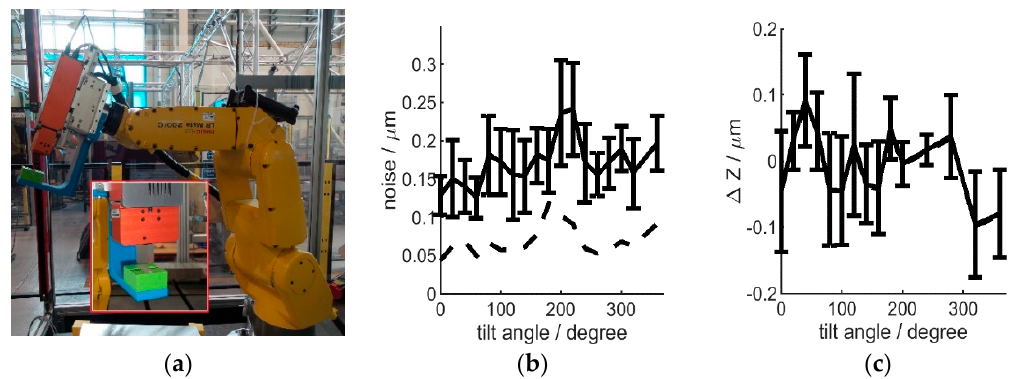
Figure 10. Influence of instrument tilt, setup shown in ( a ) noise results in ( b ) and step-size results in ( c ), the standard deviation is shown by the error bars.